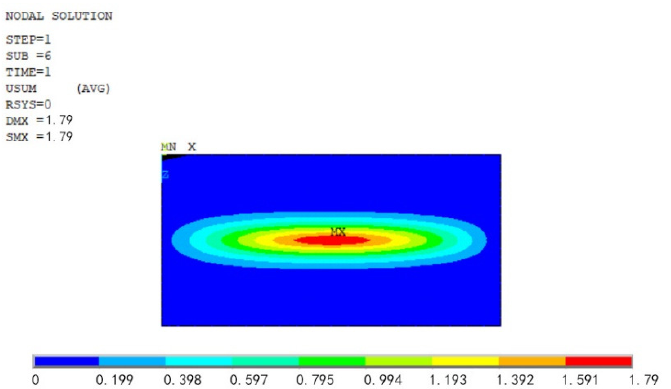
Figure 22. Vertical displacement distribution of timber floor model (unit: mm).